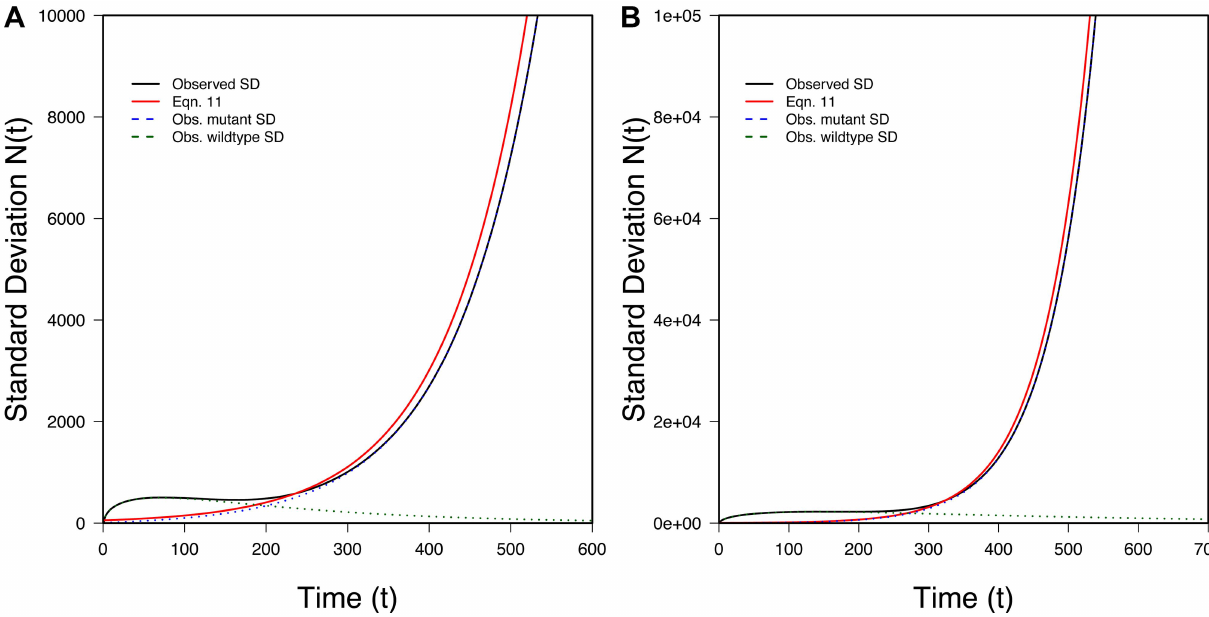
Figure 4. The variance in population size during evolutionary rescue. Observed variance of total population size (black), predicted from Eq. 11 (red), variance in the number of mutants (dotted blue), variance in number of wildtype (dotted green). A) N 0 =10,000, r =0.01, s =0.02, k =10; B) N 0 =100,000, r =0.005, s =0.02, k =3; 100;000 realizations.